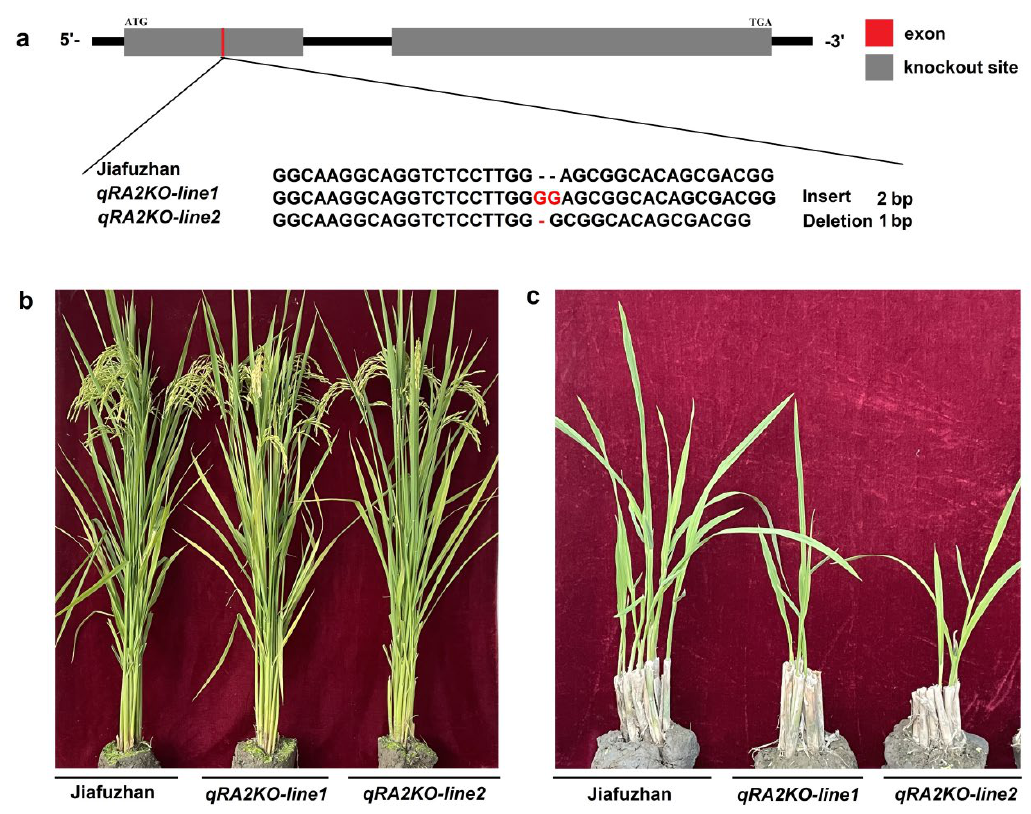
Figure 3. qRA2 − knockout lines generated using CRISPR/Cas9 technology and exhibiting the NIL128 phenotype. ( a ): Two independent events (designated qPA2KO − line1 and qPA2KO − line2 ) were generated using the CRISPR/Cas9 system and verified by sequencing. ( b ): Plant phenotype of Jiafuzhan and two knockout lines. ( c ): Ratooning ability comparison of Jiafuzhan and two knockout lines.